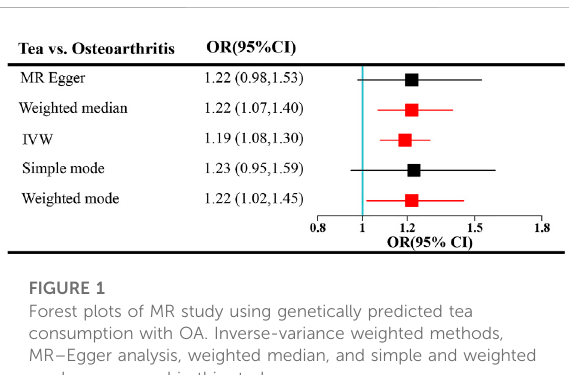
FIGURE 1 Forest plots of MR study using genetically predicted tea consumption with OA. Inverse-variance weighted methods, MR – Egger analysis, weighted median, and simple and weighted modes were used in this study.